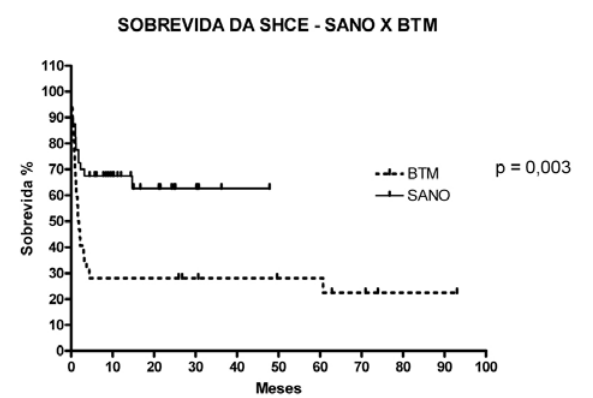
Fig. 5 - Curva de sobrevida em longo prazo - BTM= Blalock Taussig modificado